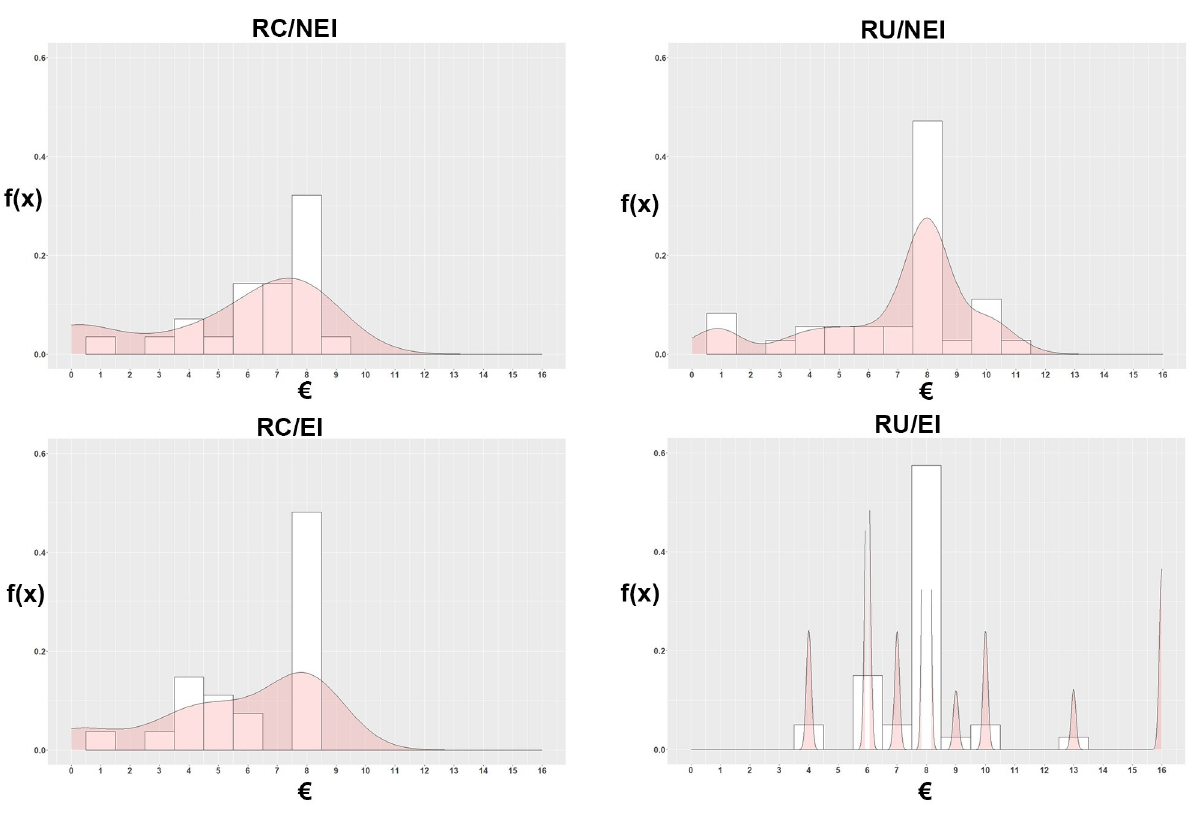
Fig 1. Distribution of allocations in each